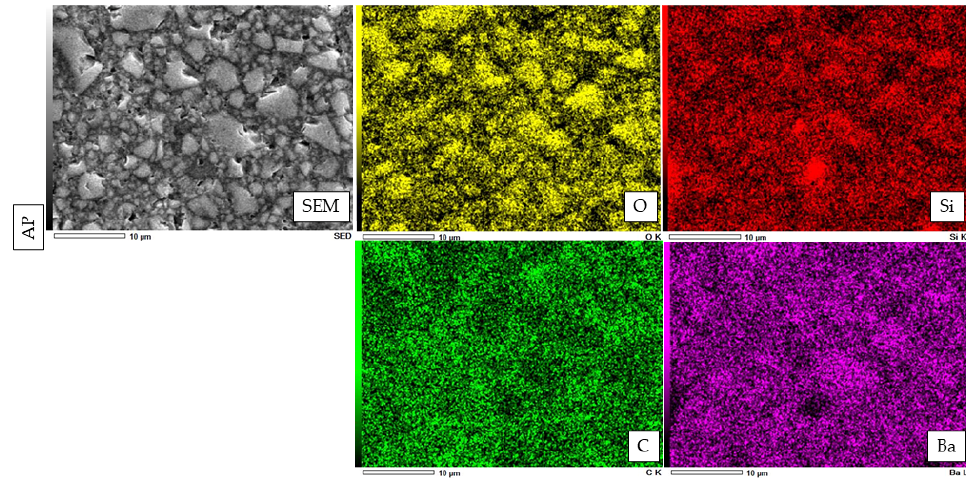
Figure 8. The representative EDX evaluation image of AP at ×3000 magnification.